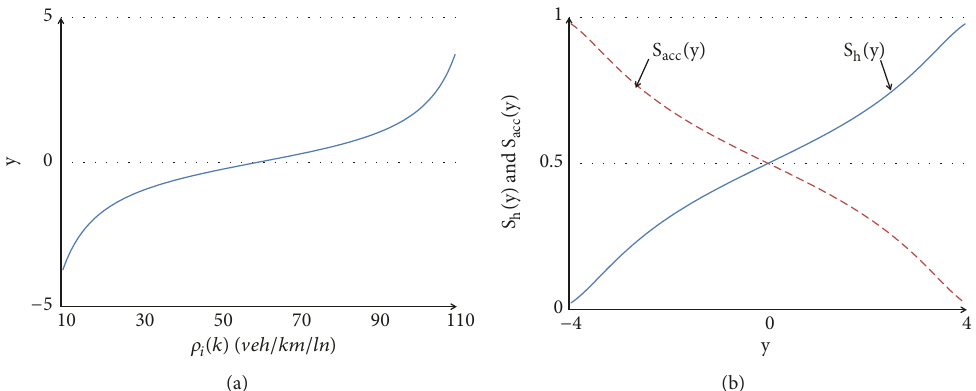
Figure 2: Interpretationof the term △𝑥 : (a) the formulated sensitivity y along density 𝜌 𝑖 (𝑘) and (b) RELATIONSHIPS between 𝑆 ℎ (𝑦) , 𝑆 𝑎𝑐𝑐 (𝑦) , and 𝑦